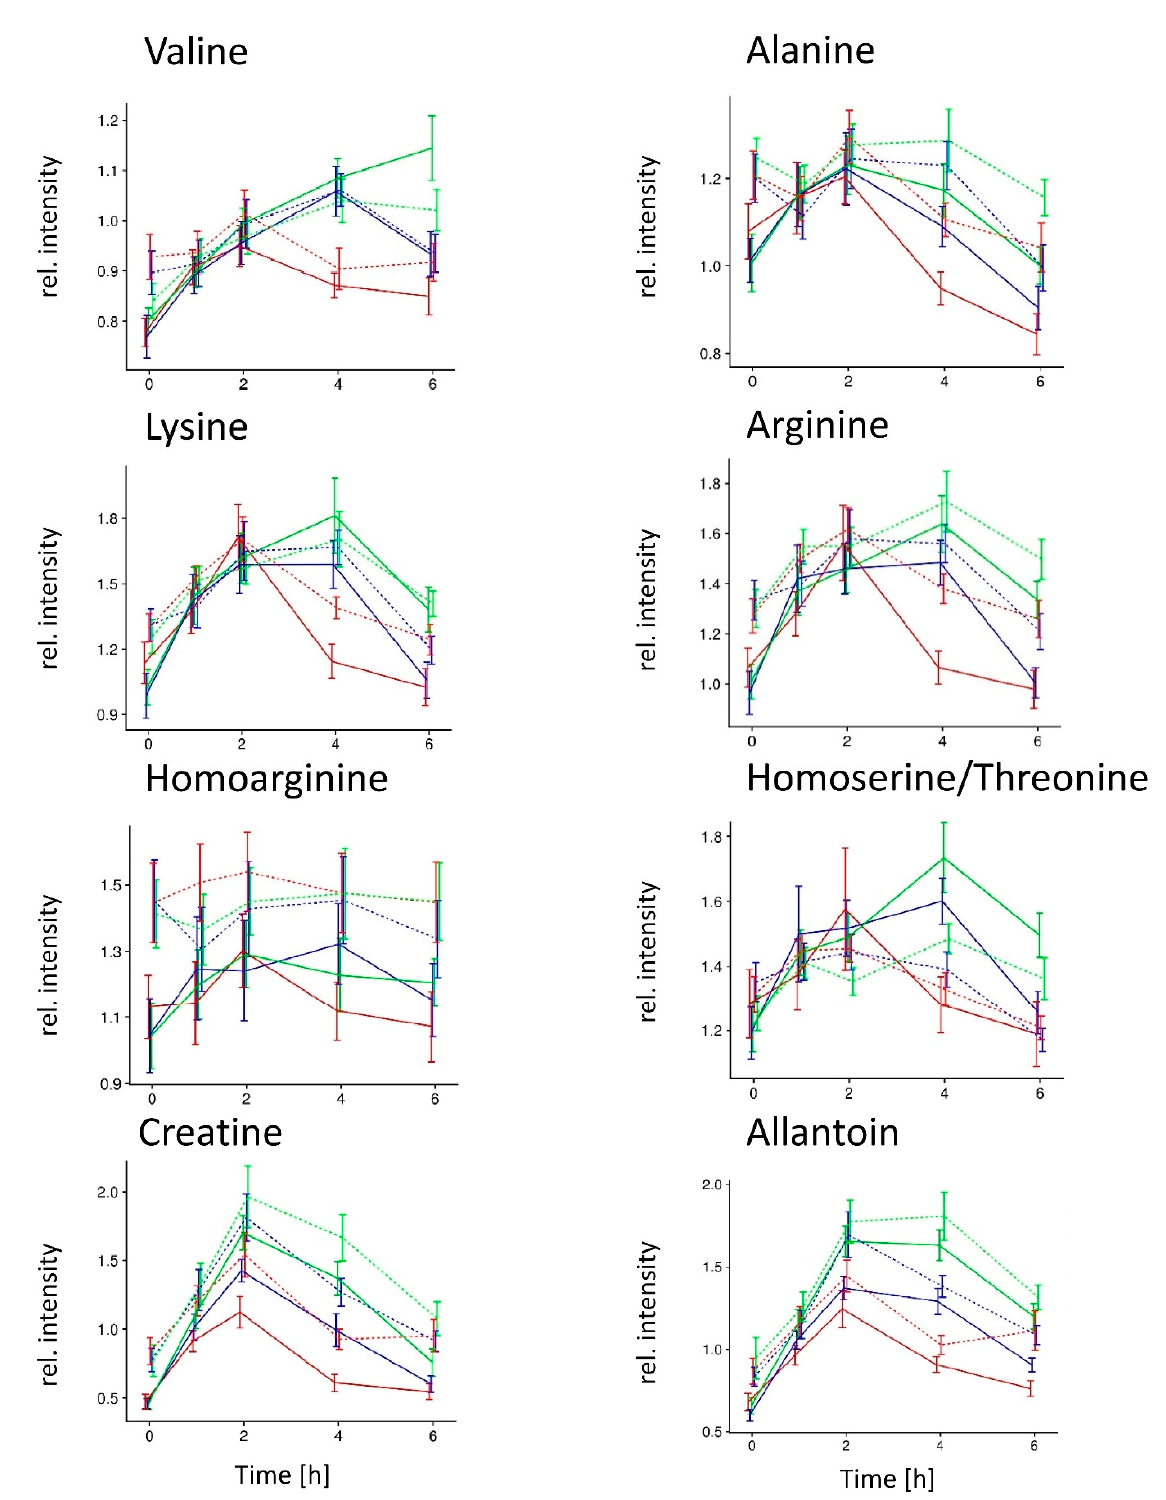
Figure 4. Postprandial kinetics of seven compounds with level 1 and homoserine/threonine with level 3 identification (0–6 h) in normal weight (NW) and obese (OB) group after consumption of three caloric doses of HF meals (A = 500, B = 1000, C = 1500 kcal). The kinetic profile of allantoin after ingestion of 500 kcal of the HF meal by the NW group was dominated at 2 h by an outlier value of a single subject (intensity of 32.6), which was much higher than for all other subjects (intensities ranging from 0.5 to 1.8). This data point was kept for the non-parametric statistical analyses but removed for the graphical representation of the postprandial kinetics of allantoin.